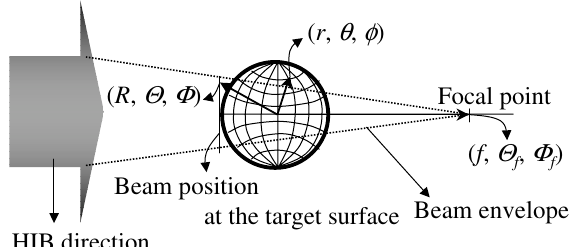
; (cid:28) ) is the f f